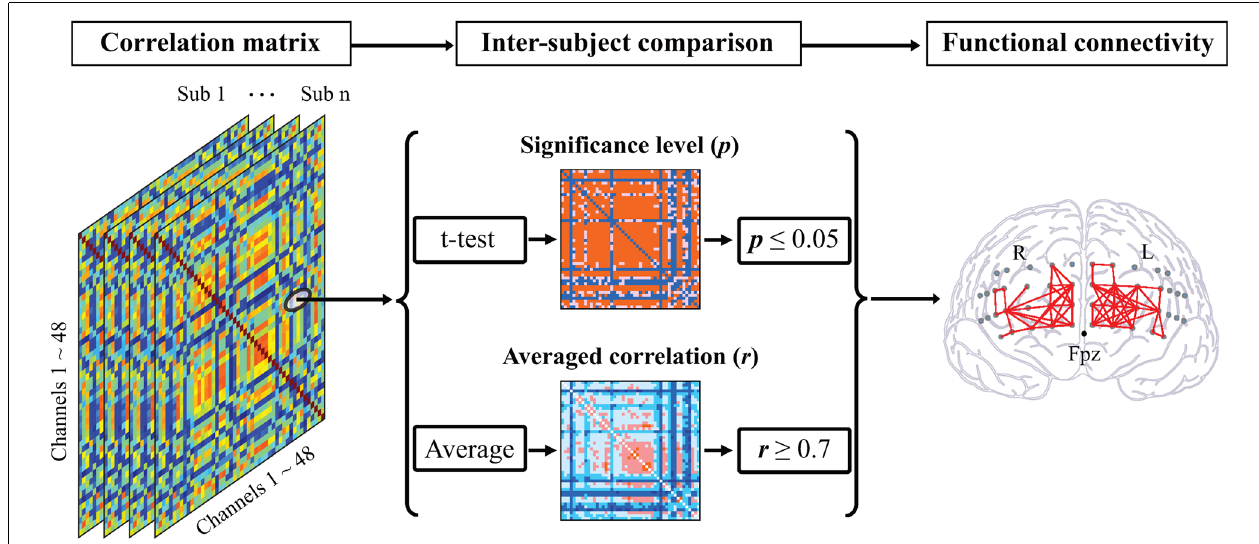
FIGURE 2 | Illustration of functional connectivity analysis. A correlation matrix was calculated for each participant composed of Pearson’s correlation coefficients between each two channel pairs. For comparison within participants, the statistical significances of correlation for all pairs were computed based on a one-sample t -test followed by the log-transformation using Fisher’s z -transformation. By averaging the correlation matrices of all participants, the functional connectivity between two channels was identified as the high correlation coefficient ( r ≥ 0.7) and the statistical significance ( p ≤